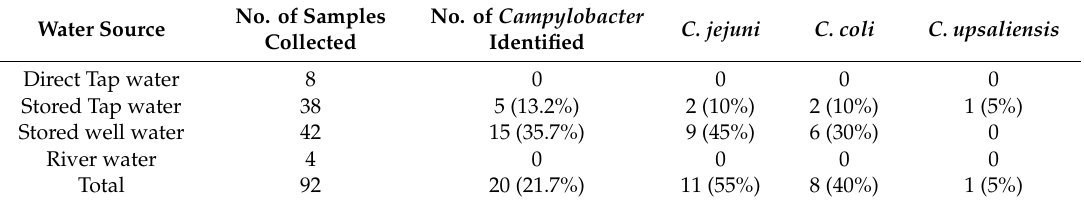
Table 2. Distribution of Campylobacter spp. based on water source and point of collection. Water